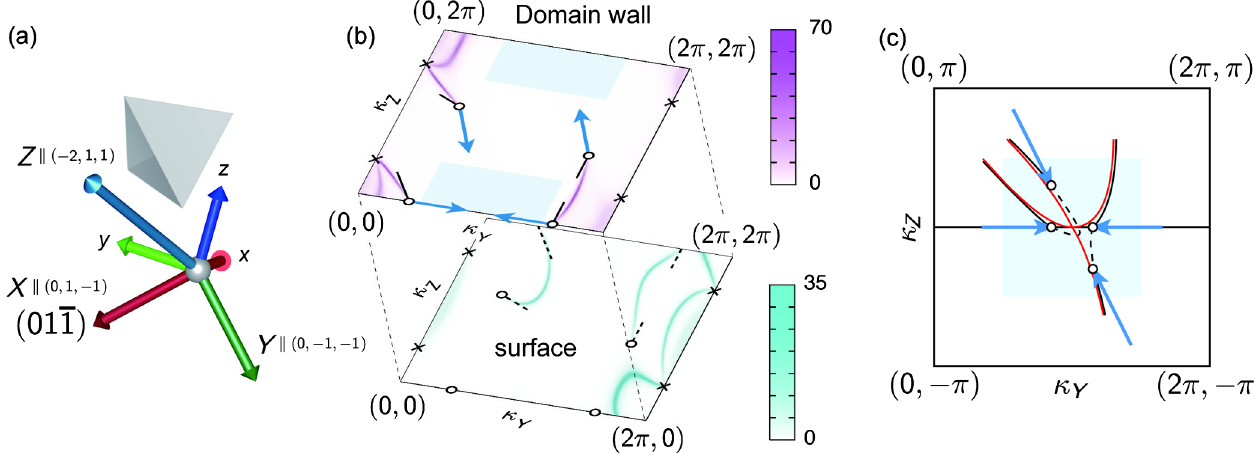
ˆ ~ ψ ð X Þ ¼ E~ ψ ð X Þ . (a) Newly introduced coordinate h ð(cid:2)Þ FIG. 3. Summary of solutions for effective one-dimensional Dirac equations Γ ~k 01¯1 Weyl axes X , Y , and Z are illustrated for the ð Þ domain wall. (b) Zero modes of the chiral Dirac equations with low-energy ~k · ~p ˆ ˆ ffiffi ffiffi h ð(cid:2)Þ h ð(cid:2)Þ Hamiltonians including [Eq. (9)] and (see Appendix D). Open circles indicate the four Weyl points projected Γ κ 0 = Γ κ 0 = 3 p ð 1 ; 1 ; 1 Þ 3 p ð − 1 ; 1 ; 1 Þ ffiffiffiffiffiffiffiffiffiffiffiffiffi p ffiffiffiffiffiffiffiffiffiffiffiffiffi p ; κ plane at ~k to the ð κ j m j = 2 t ð 1 ; 1 ; 1 Þ and ~k Weyl ¼ (cid:2) j m j = 2 t ð − 1 ; 1 ; 1 Þ . Crosses indicate the other four bulk Weyl points. Y Z Þ Weyl ¼ (cid:2) Solid (dashed) lines represent the initial slopes of the loci of the domain-wall (surface) states starting from the Weyl points obtained from Eq. (2), where the full solution of Eq. (1) is illustrated by a color contour plot. Small deviations of the solid (dashed) black lines from the expectation from the contour plot may be ascribed to the small error arising from the reduction from the four-component Luttinger Hamiltonian to the two-component Hamiltonian (9), where off-diagonal elements in the order of k 2 are ignored. For m → 0 , solid curves shrink and disappear at (0,0). Arrows indicate the directions along which the projected Weyl points move when j m j increases. ; κ (c) Qualitative description for pair annihilation of bulk Weyl electrons on the ð κ plane. Solid (dashed) curves illustrate the loci of Y Z Þ the domain-wall (surface) zero modes. When the projected Weyl points move along the direction indicated by the arrows originally π ; 0 Þ . Then, the closed loop of the Fermi surface on the domain walls ; κ starting from (0,0), the pair annihilation occurs at ð κ Y Z Þ ¼ ð appears, which is represented by the solid red curves. Note that the Brillouin zone is shifted ð 0 ; π Þ from (b). The shaded regions in (b) and (c) represent the same